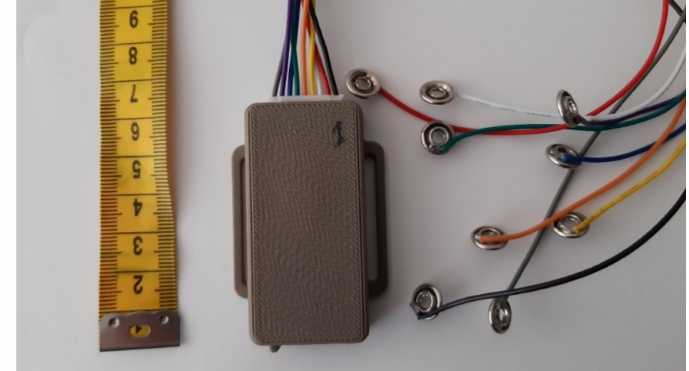
Figure 3. The data acquisition unit can measure up to eight channels and is connected to the system through textile snap fasteners. The unit measures only 6.6 cm × 4 cm × 1.3 cm and is positioned in a pocket on the back, and, thus, does not bother the